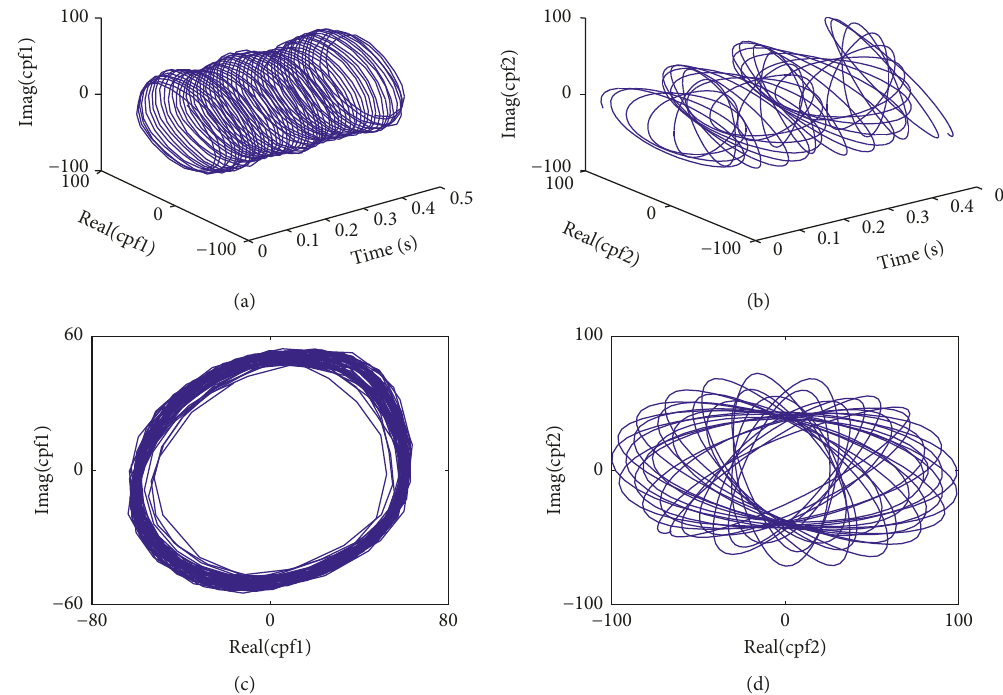
Figure 13: The first two decomposed results of the filtered signal based on the CLMD